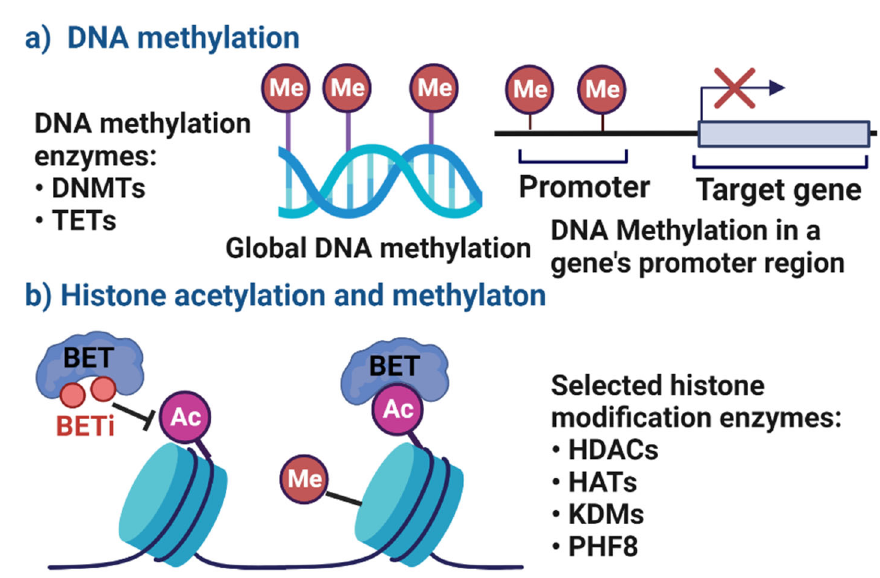
Figure 1. A schematic overview of epigenetic modifications to gene expression, regulated by DNA methylation enzymes ( a ) and histone modification enzymes ( b ). Ac, acetylation; DNMTs, DNA methyltransferases; HATs, histone acetyltransferases; HDACs, histone deacetylases; KDMs, histone demethylases; Me, methylation; PHF8, PHD finger protein 8; TETs, ten-eleven translocation family of enzymes. BET: bromodomain and extra ‐ terminal proteins; BETi: BET inhibitors.